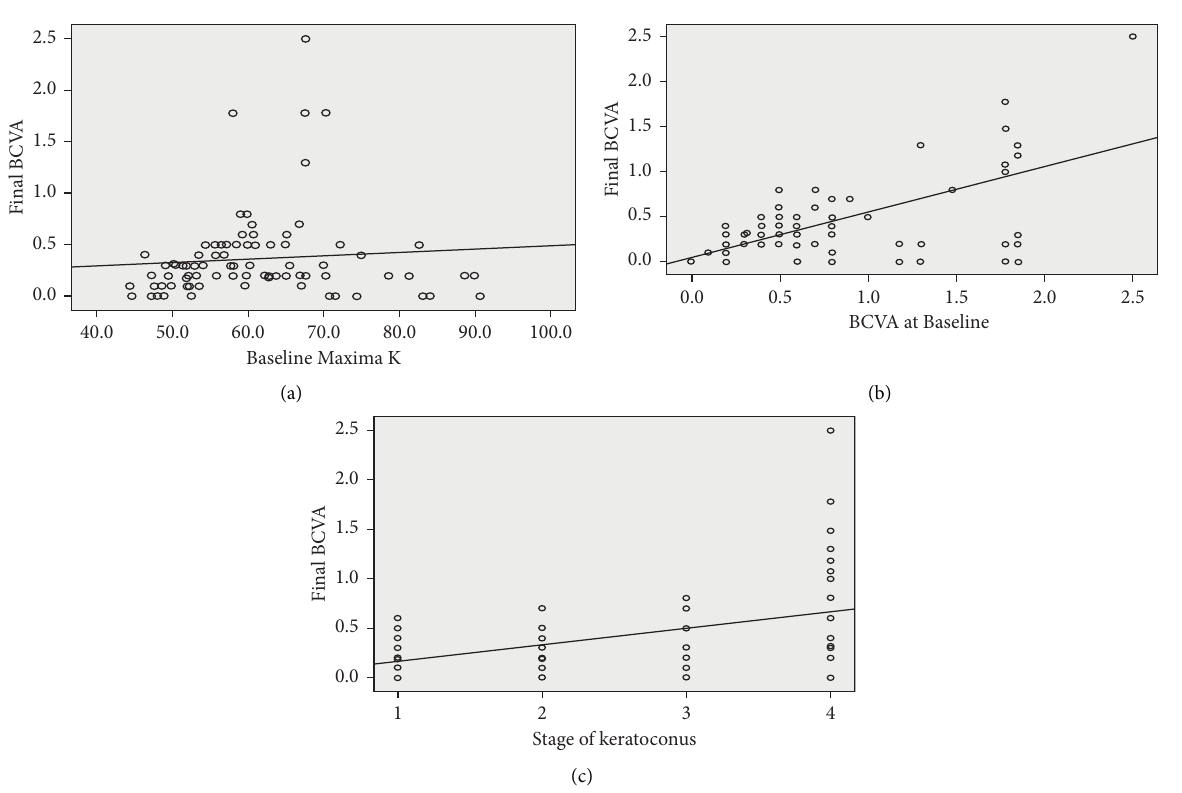
Figure 3: Significant positive correlation of BCVA at the final follow-up after CXL with (a) baseline BCVA ( p � 0 . 001), (b) baseline Kmax ( p � 0 . 001), and (c) stage of KC ( p � 0 . 01).